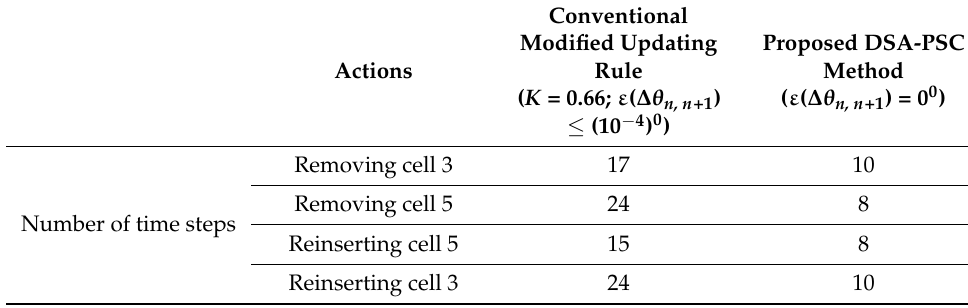
Table 6. Evaluate the system reconfiguration time for a six-cell converter.